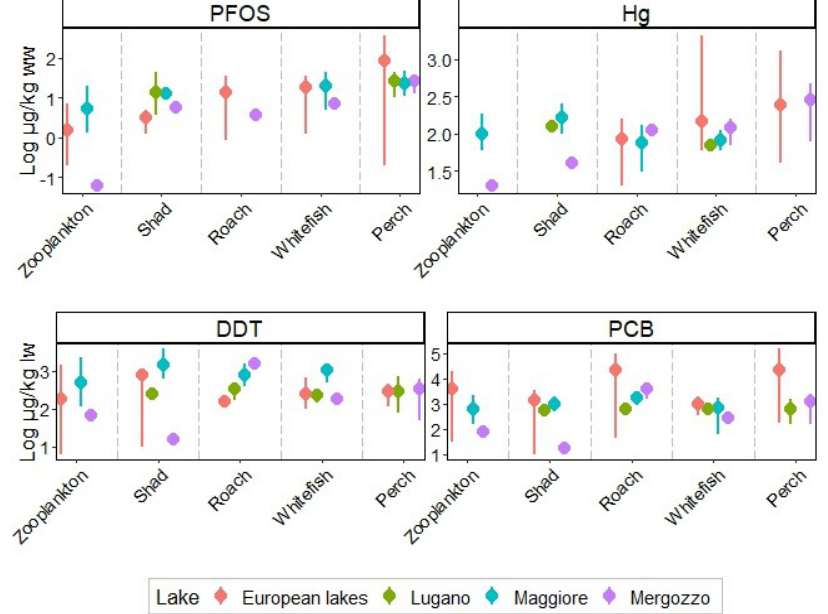
Figure 2. Data comparison among the results of this study (in violet) and chemicals concentrations recorded in European lakes (in red), Lake Lugano (in green) and Lake Maggiore (in blue). Concentrations are expressed in logarithmic concentrations. Filled dots and bars represent average value and range, respectively. Detailed data are reported in Table S6. PFOS: perfluorooctanesulfonate, Hg: mercury, DDT: dichlorodiphenyltrichloroethane and metabolites and PCB: polychlorinated